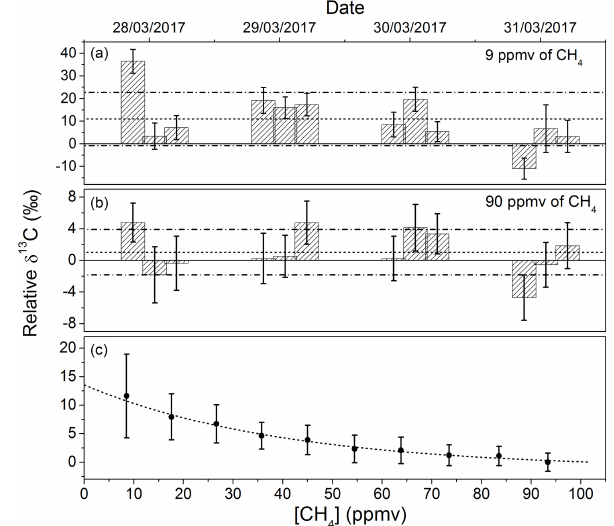
Figure 5. (c) The dependency of the relative δ 13 C-CH 4 on the CH 4 concentration. (a, b) Reproducibility between discrete mea- surements made three times a day for 1 week for 9 and 90ppmv of CH 4 in dry air. Accuracies of ± 11 . 8‰ and ± 2 . 9‰ (represented by the dashed lines) were obtained for the two concentrations (1 σ ). The instrument was not calibrated before each measurement using a gas standard. For high concentrations, such calibration would make the accuracy approach the expected precision of 0.08‰ after 5min of integration